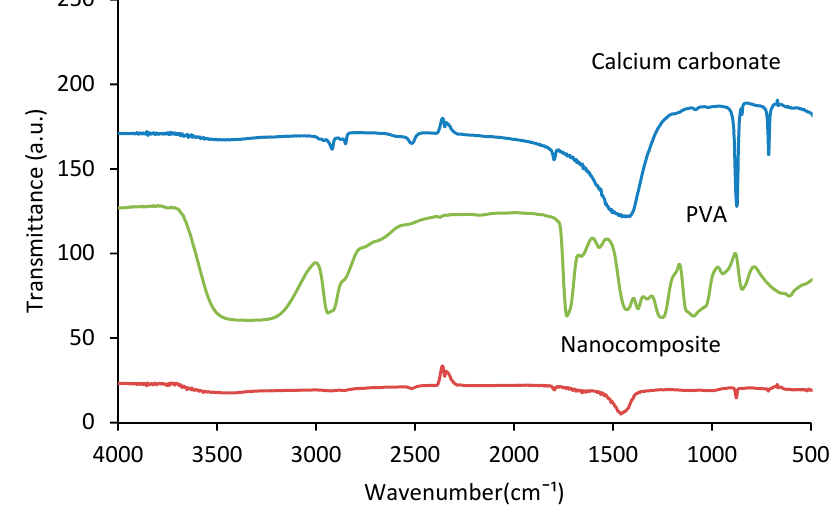
Figure 2. Fourier transform infrared (FTIR) spectroscopy of PVA, calcium carbonate, and PVA/ CaCO 3 nanocomposites.